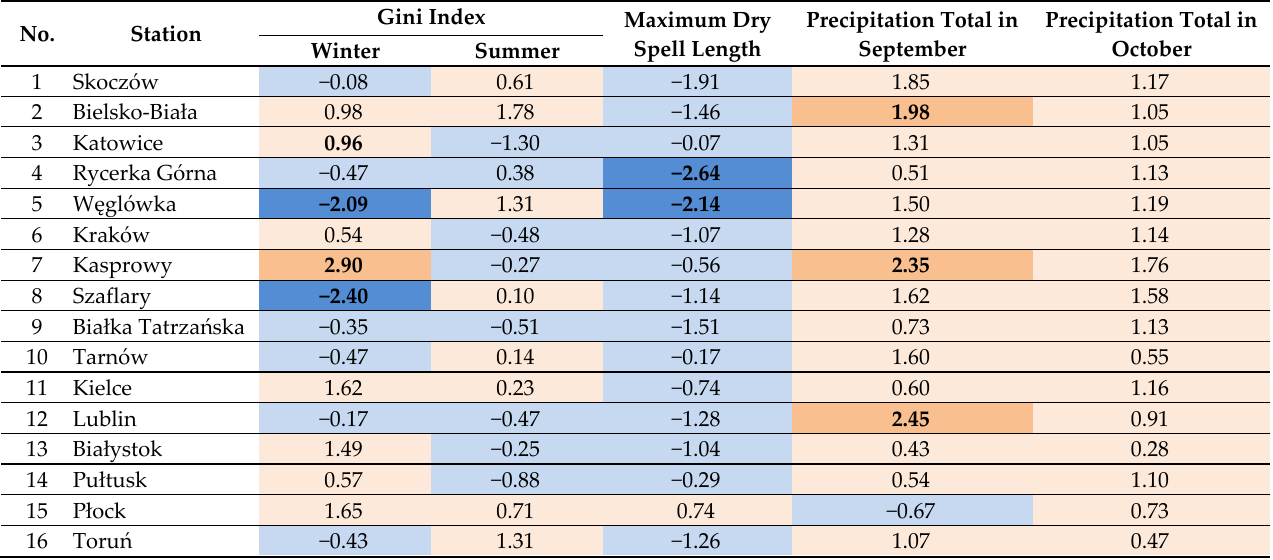
Water 2021 , 13 , x FOR PEER REVIEW Table 11. Results of the Mann test ( uF statistics) for trends in precipitation characteristics in the seasonal and annual time scales; orange colour denotes positive uF values, blue colour negative. Numbers in bold indicate statistically significant changes at α level 0.05.